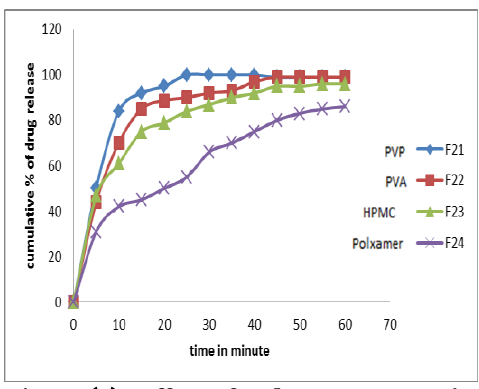
Figure (6): Effect of polymer type on the dissolution profile of ezetimibe nanoparticles from F21, F22, F23, and F24 in phosphate buffer (pH 6.8) containing 2% brij-35 w/v at 50 r.p.m and 37˚C